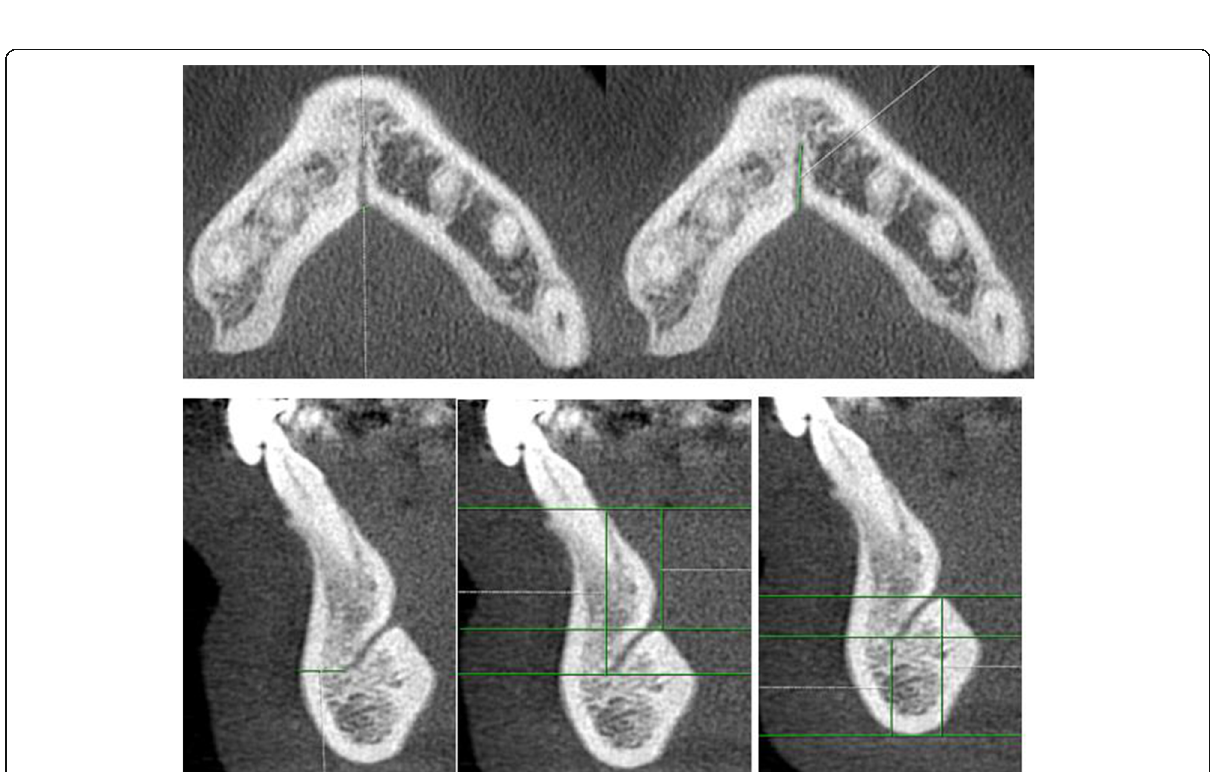
Fig. 3 CBCT measurements in 31-year-old male